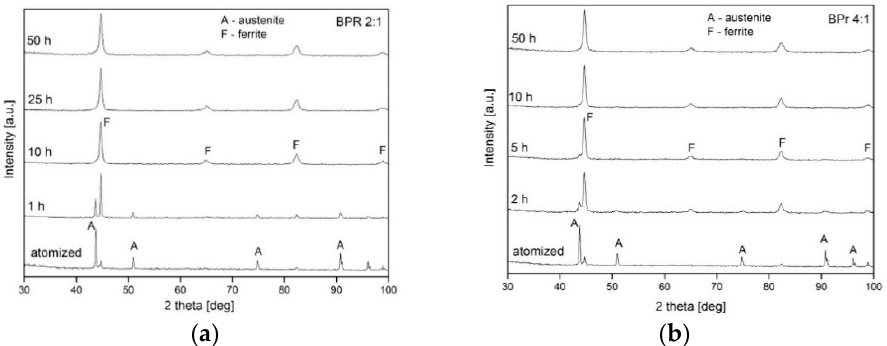
Figure 2. ( a ) XRD patterns recorded for the powders milled up to 50 h, BPR 2:1; A—austenite, F—ferrite; ( b ) XRD patterns recorded for the powders milled up to 50 h (BPR 4:1); A—austenite, F—ferrite.